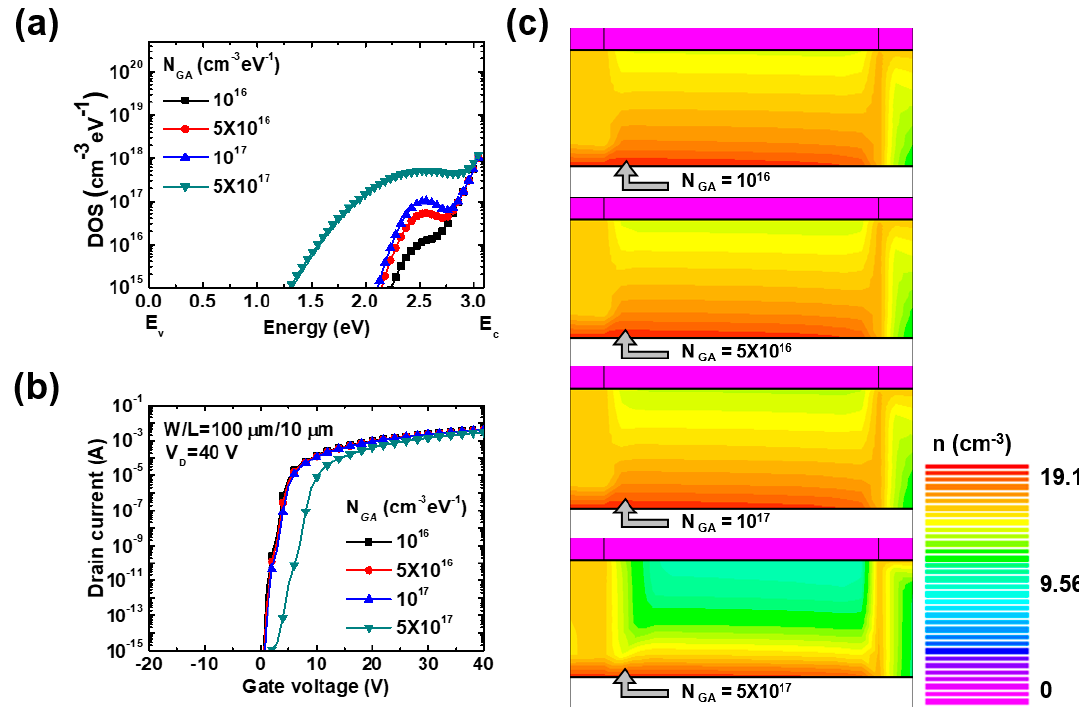
Figure 3. ( a ) DOS in sub-gap is shown as a function of energy. The Gauss donor-like states ( N GA ) are controlled from 10 16 to 5 × 10 17 cm − 3 eV − 1 . ( b ) Drain current according to applied gate voltage is shown at 40 V of drain voltage. ( c ) Each layer depicts the electron concentration distribution from top to bottom of N GA ranging from 10 16 to 5 × 10 17 cm − 3 eV − 1 at the saturation region 40 V of gate voltage and 40 V of drain voltage. The color table displays the electron concentration variations of 0–10 19.1 in varying colors.